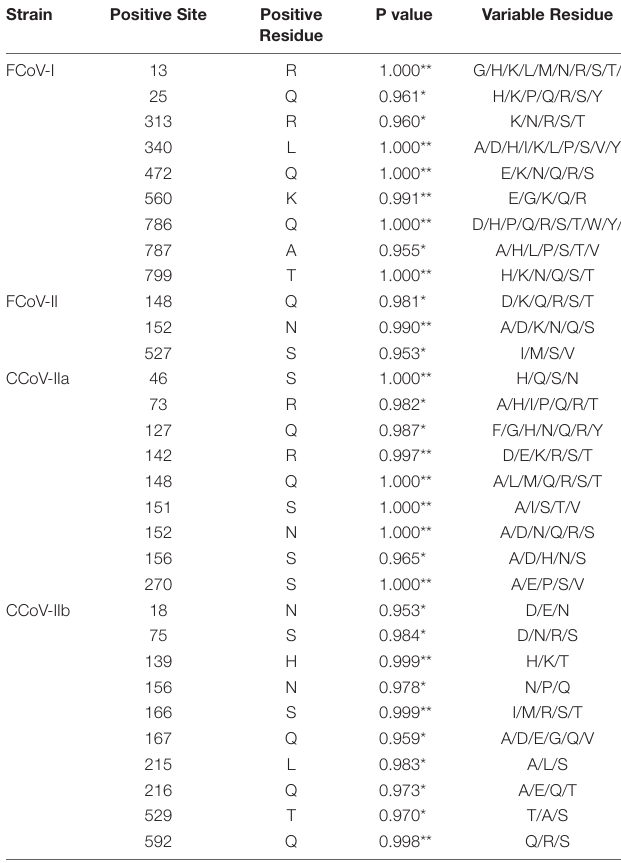
TABLE 1 | Positive selection analysis of